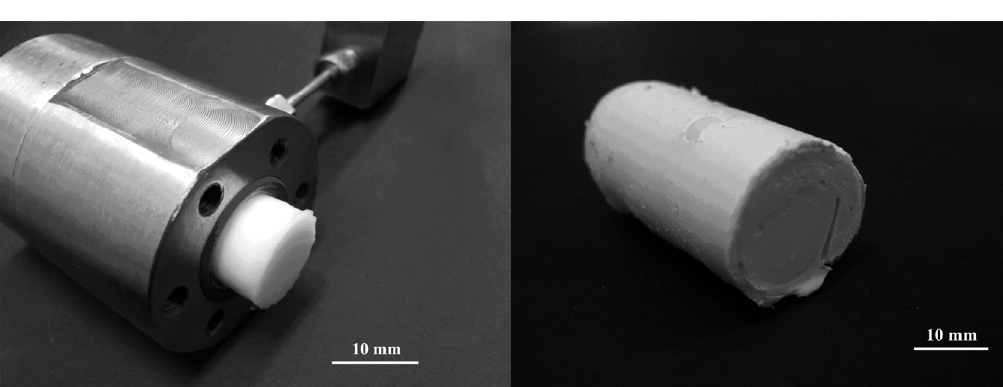
Cloud point pressure of P(VAc- stat -CF